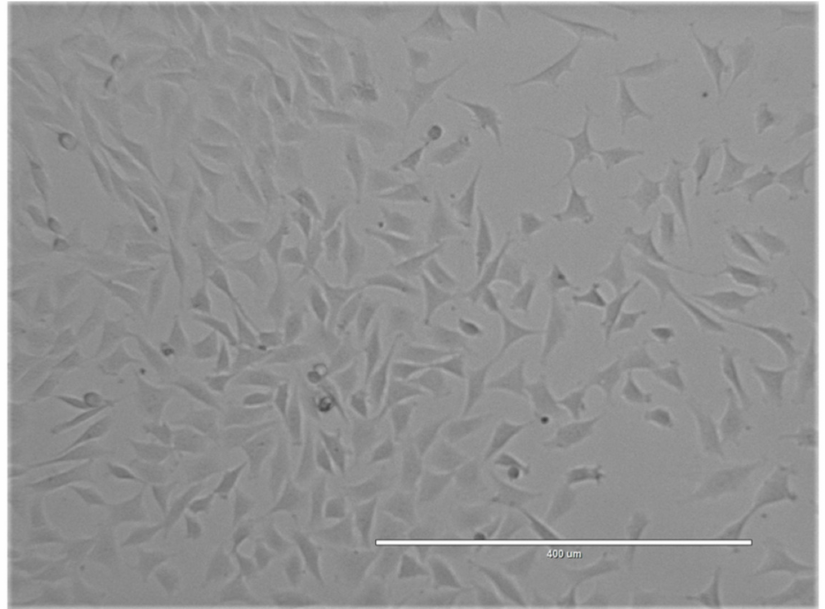
Figure 2. Expansion in culture of nasal chondrocytes derived from sheep nasal